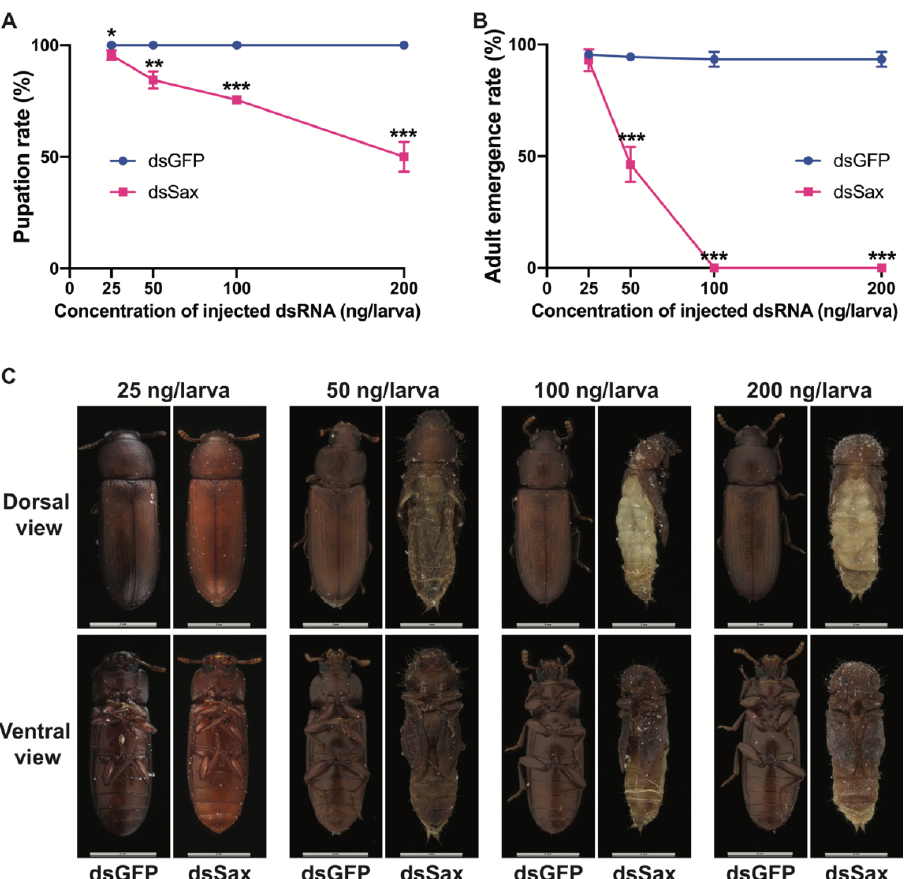
dsSax (100 ng/larva)-treated groups. The red arrows indicated the normal eye and abnormal eye development in the Sax RNAi larva. NS indicated non-significant differences between the treatment and corresponding control, p > 0.05 by t -test, asterisks above bars indicate significant differences